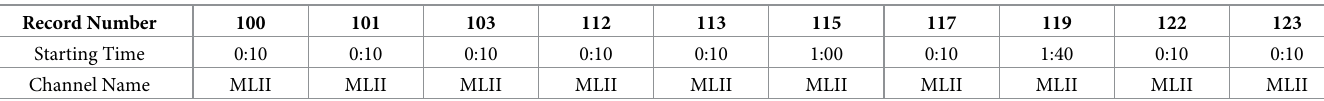
Table 2. Real ECG data chosen from the MIT-BIH Arrhythmia